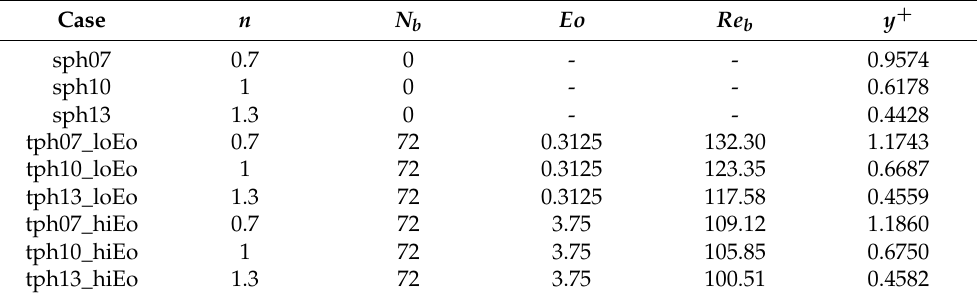
Figure 3. Grace diagram for bubble shapes [34]. Purple point and lines specify case “tph10_loEo”, blue point and lines specify case “tph10_hiEo”. Table 1. DNS case overview in terms of power-law index n , bubble count N b , Eötvös number Eo , bubble Reynolds number Re b , and dimensionless distance from the wall y +